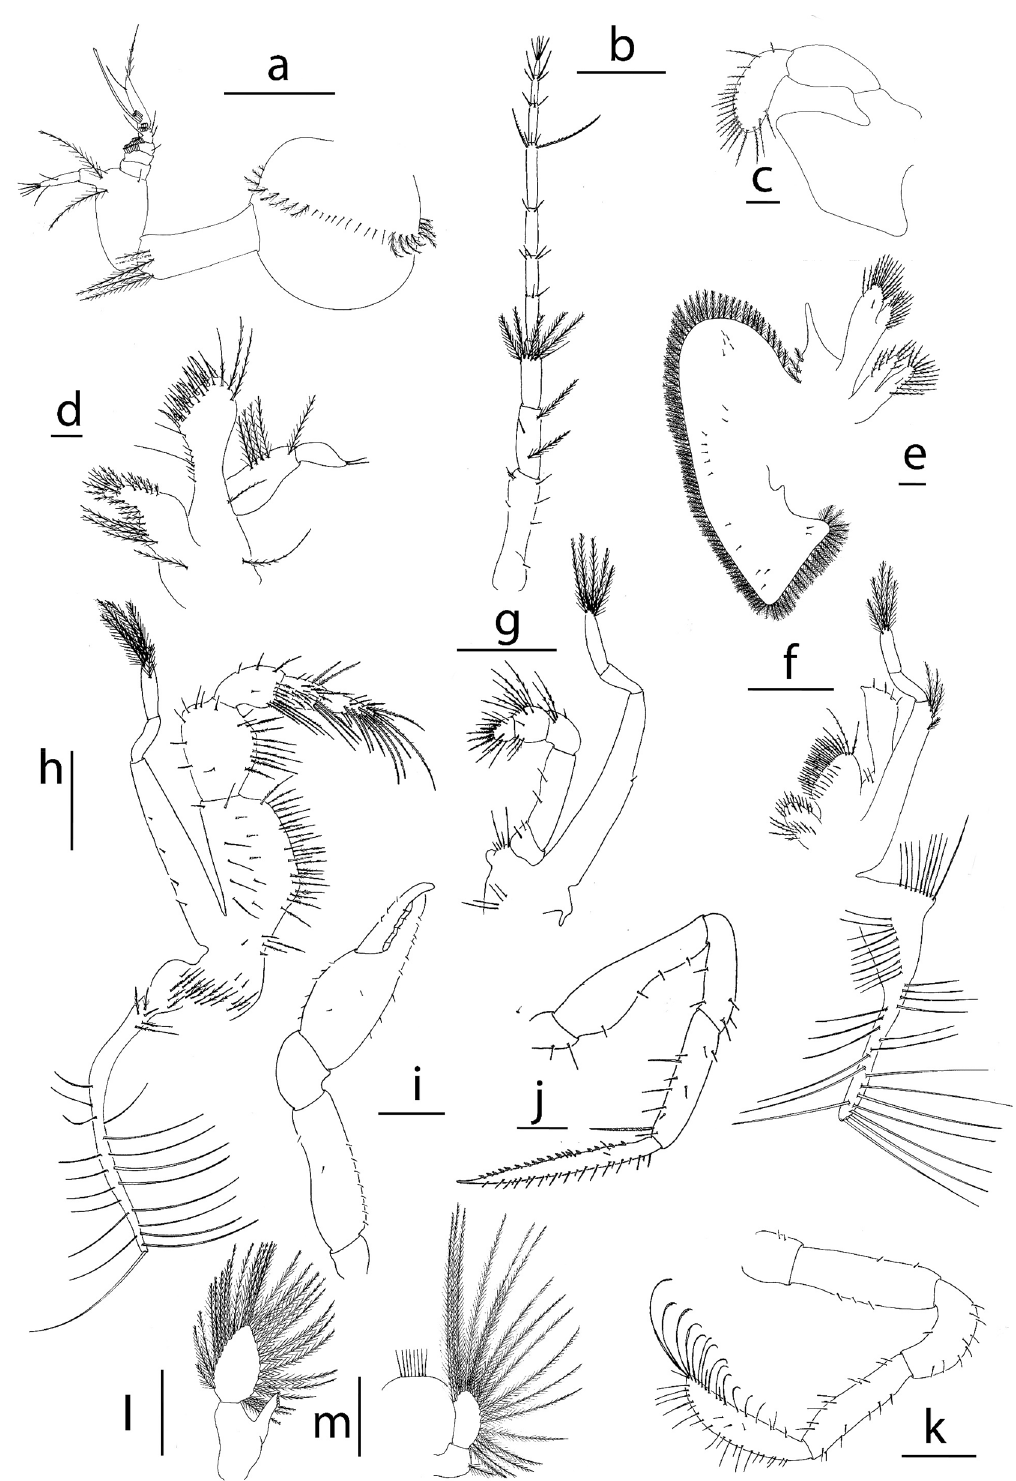
Figure 3. Appendages of Achelous floridanus megalopa: ( a ) antennule; ( b ) antenna; ( c ) mandible; ( d ) maxillule; ( e ) maxilla; ( f ) first maxilliped; ( g ) second maxilliped; ( h ) third maxilliped; ( i ) cheliped ( j ) second pereiopod; ( k ) fifth pereiopod; ( l ) second pleopod; ( m ) uropod. Scale bars: ( c – e ), 0.1 mm; ( a , b , h , j – m ) 500 µm; ( i ) 1